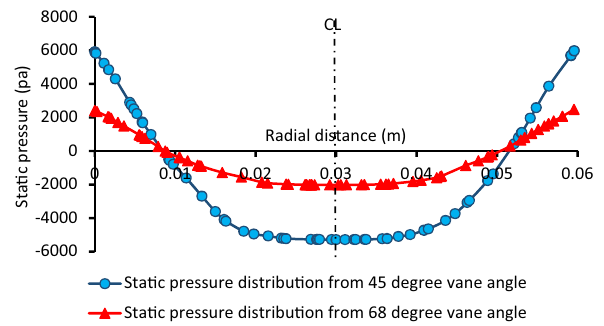
Fig. 13 Radial distribution of static pressure at Z = 90 mm of the LLHC for 45° and 68° with an inlet velocity of 2